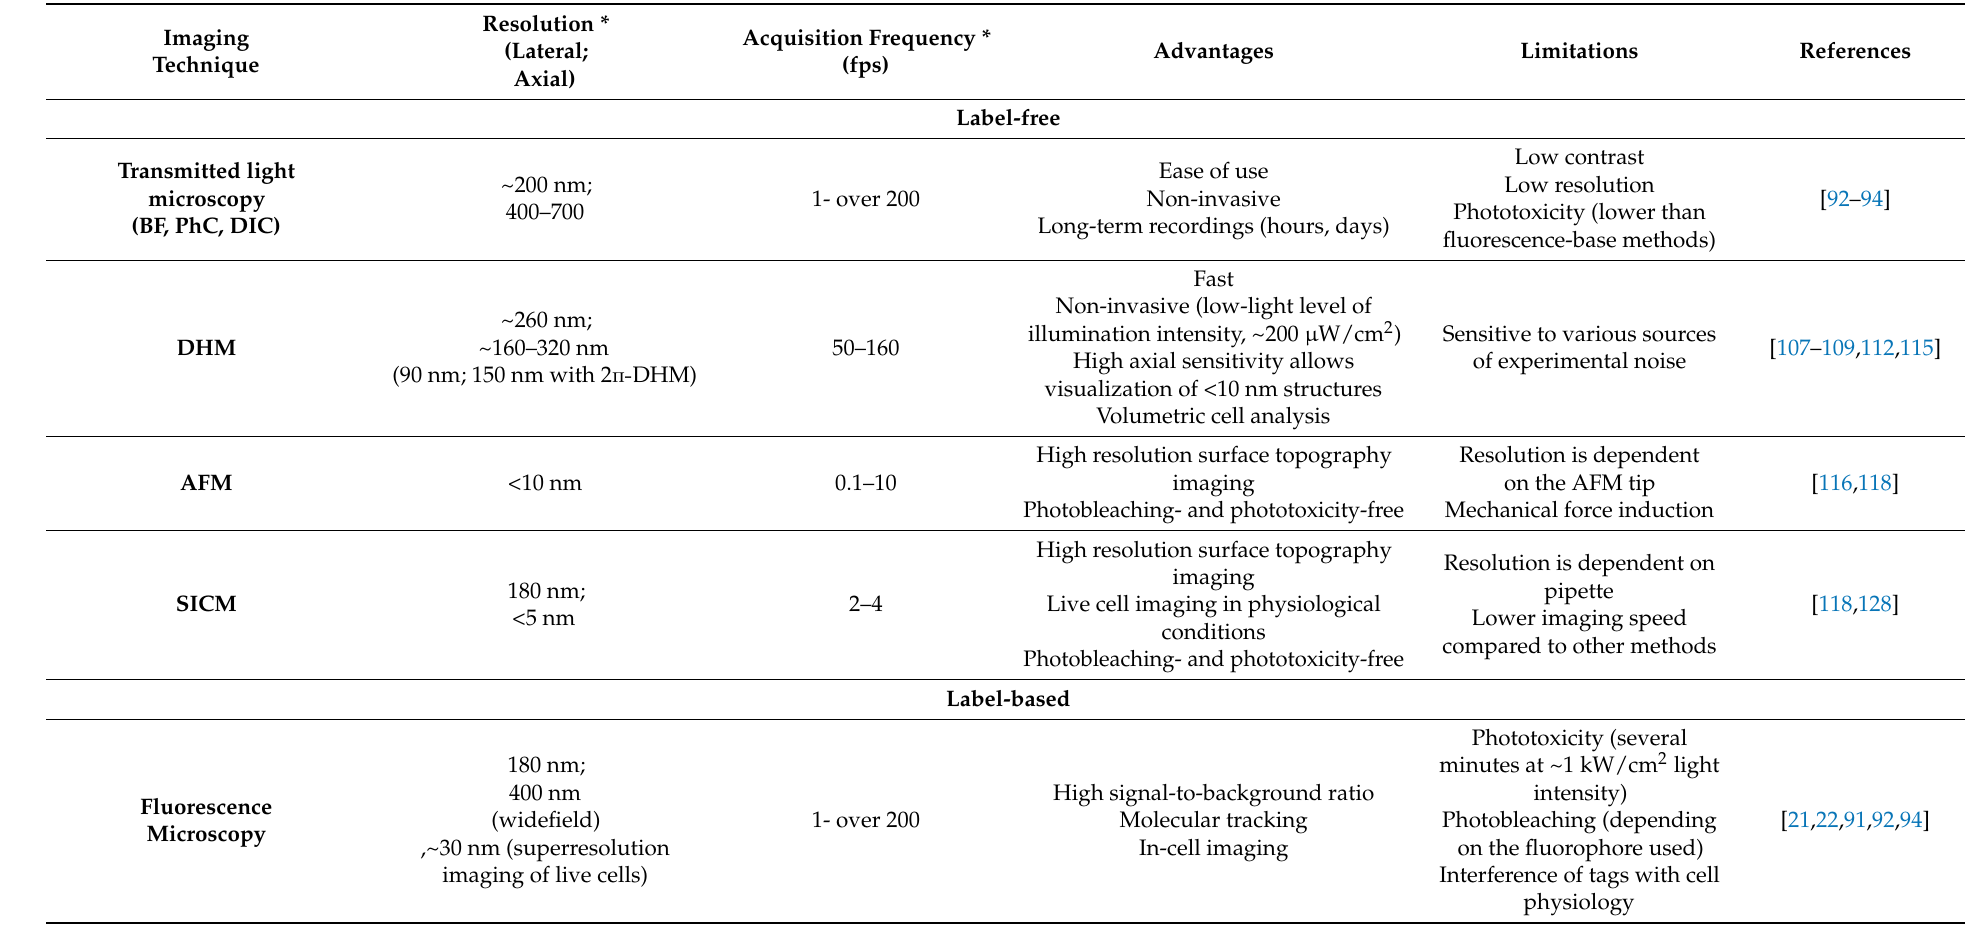
Table 1. Overview of the imaging techniques for live cell imaging of neurons. Brightfield (BF), phase contrast (PhC), differential interference contrast (DIC),